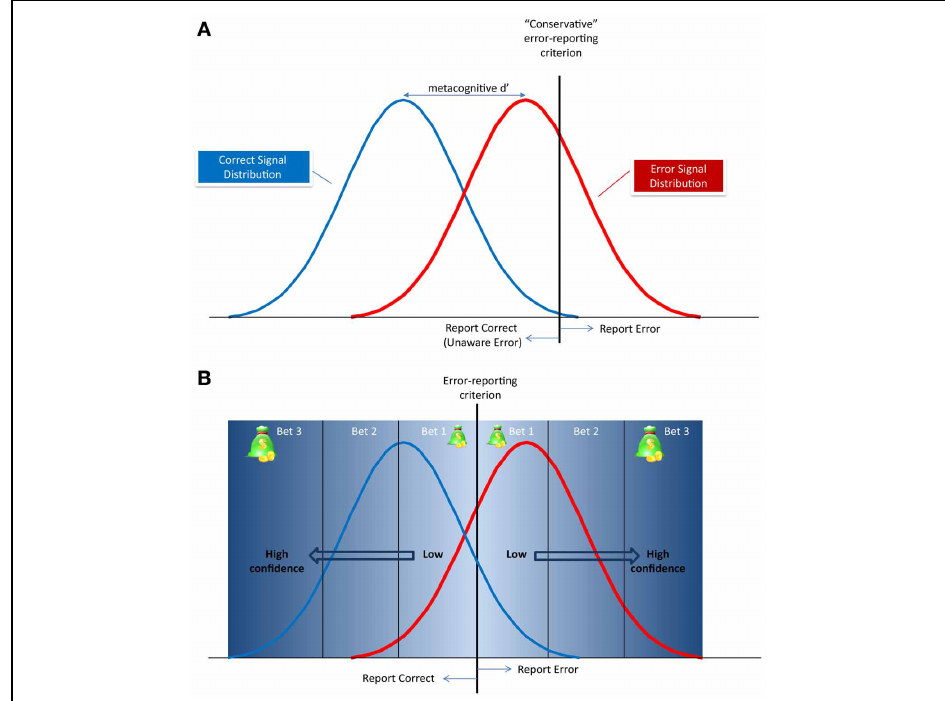
FIGURE 2 | Metacognitive signal detection model of error reporting. (A) The correct and error signal probability distributions and the decision criteria for reporting an error (vertical dotted line). The distance between the peaks of the distributions is the metacognitive d’ and defines the discriminability of an error from a correct response. In this example, the criterion is conservative, meaning that the subject will report only errors whose signal has very little overlap with the correct response signal. All other errors will be reported as “correct” as therefore, be classified as Unaware Errors. (B) The relationship between the metacognitive criterion and the subject’s confidence, or betting scheme. The further the signal is from the criterion, the higher the confidence in the metacognitive decision, and the higher subjects will be willing to